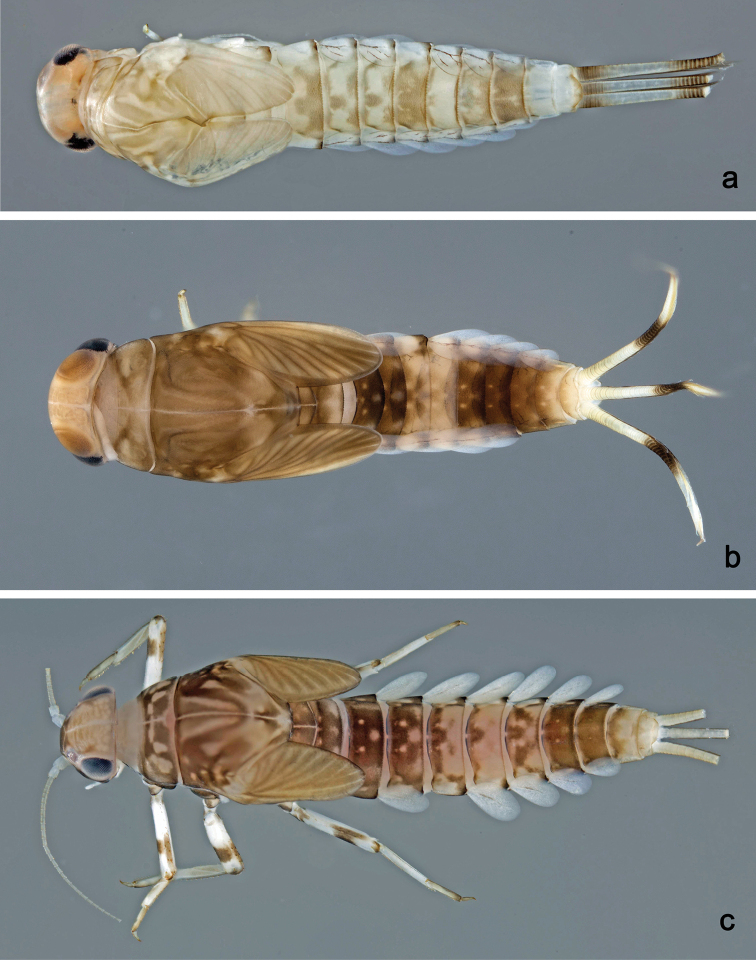
Habitus, larvae, dorsal view aLabiobaetis
dalisay sp. nov. bLabiobaetis
acei sp. nov. cLabiobaetis
aldabae sp. nov.